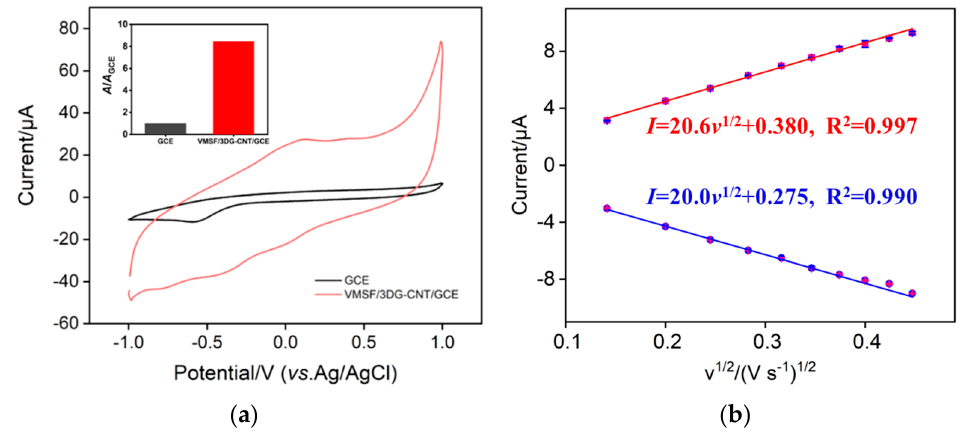
Figure 3. ( a ) CV curves of bare GCE (black) and VMSF/3DG-CNT/GCE (red) in PBS (0.1 M, pH = 6). The inset depicts the normalized electroactive surface area of each electrode. ( b ) Relationship between the peak currents and the square root of the scan rate derived from the CV curves of bare GCE in 0.05 M KHP containing 0.5 mM K 3 [Fe(CN) 6 ].